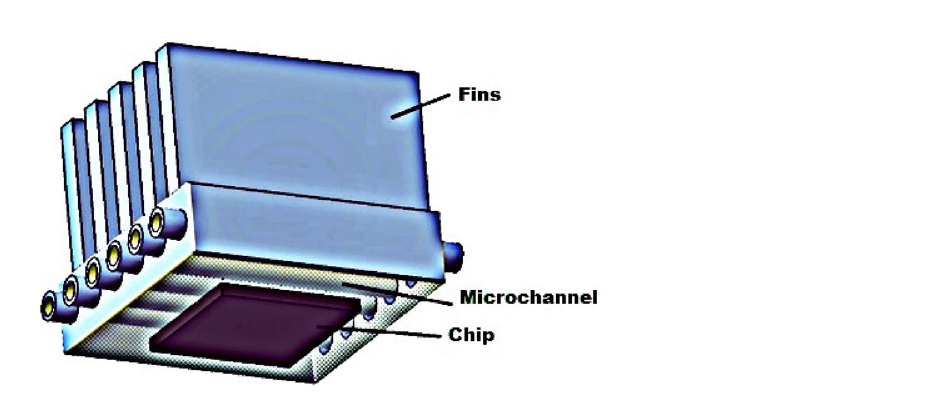
Figure 4. Geometry of Micro channel heat